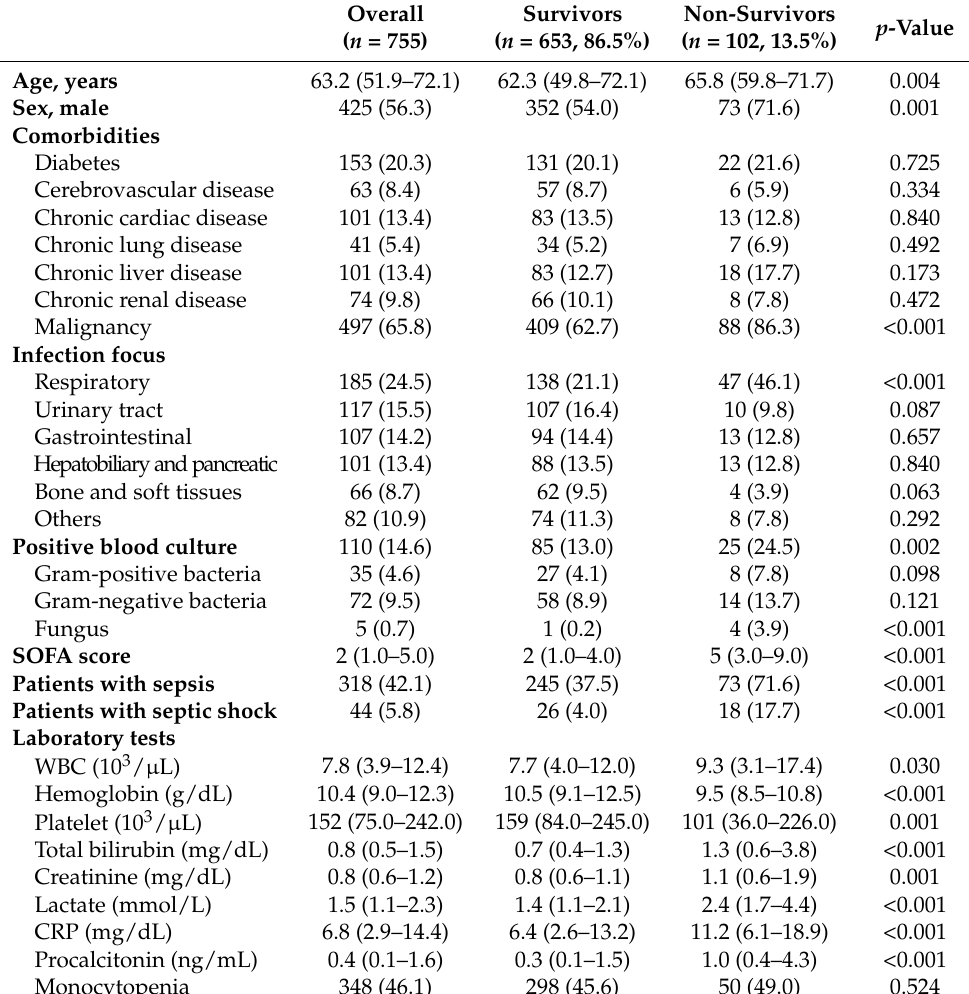
Table 1. Baseline